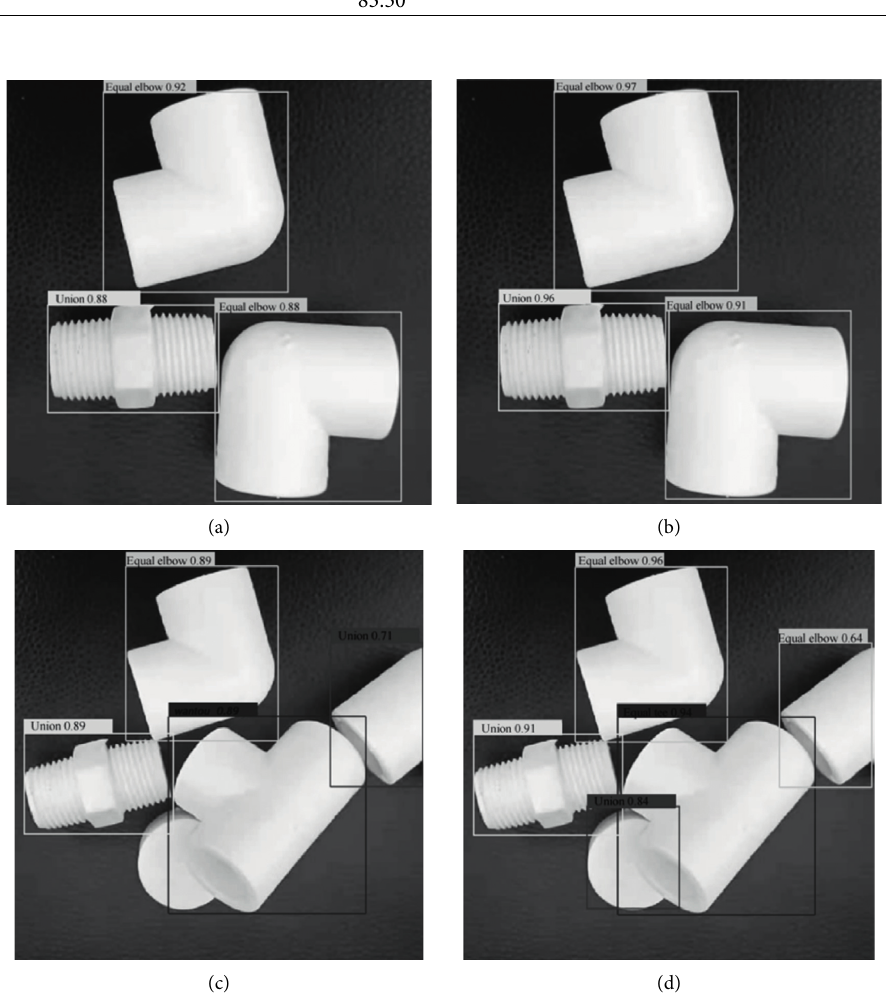
Figure 9: Comparison of single image detection results of two models. (a, c) SSD300 model. (b, d) Improved SSD model.